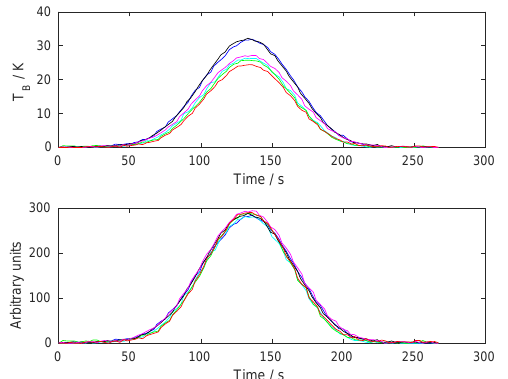
Figure 4. Moon intrusion event in different deep-space views on 17 July 2015 with MHS. The position of the Moon falls almost ex- actly between DSV 2 and 3 just so it affects the counts in all four positions. The orange line gives the number of counts in views 1 and 4 without any contribution from the Moon; it falls below the actually measured count levels from all four space views during the closest approach of the